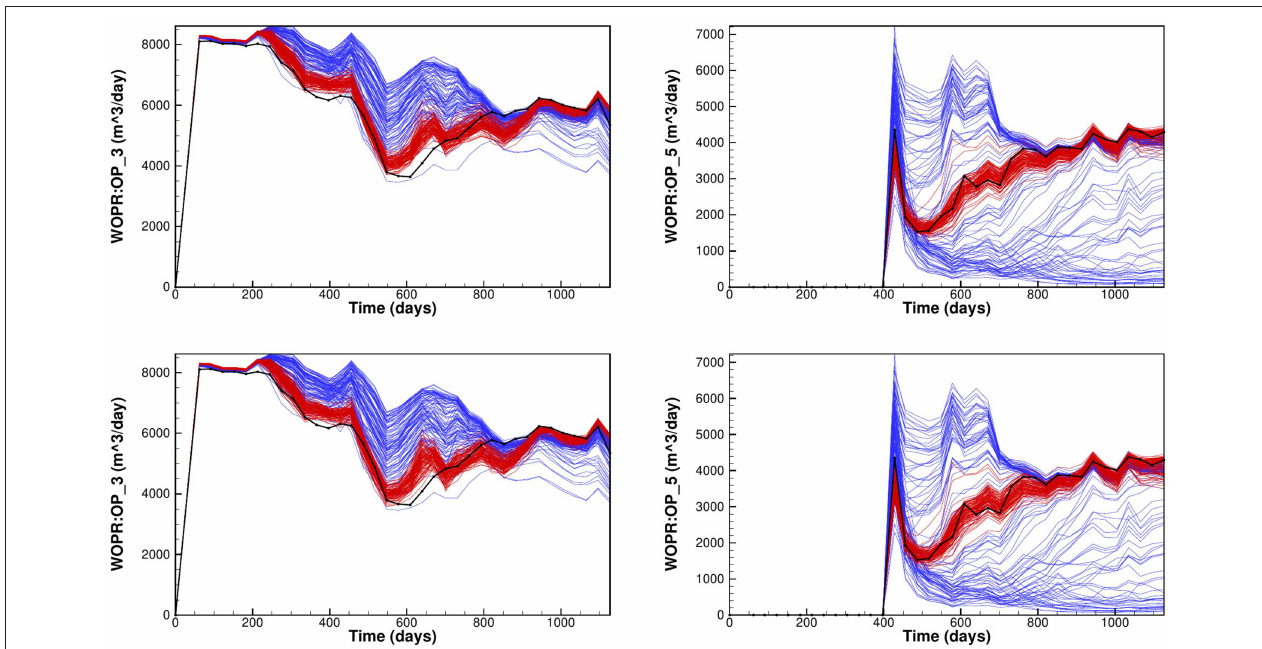
FIGURE 8 | Reservoir case: The plots show oilrates from two different wells OP3 (left plots) and OP5 (right plots) using the exact inversion (upper plots) and the subspace inversion with C dd EE T ≈